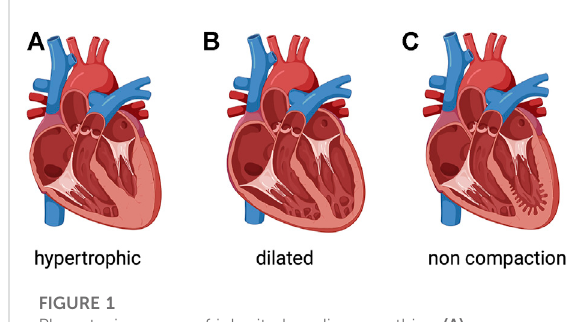
FIGURE 1 Phenotypic groups of inherited cardiomyopathies. (A) Hypertrophic cardiomyopathy involves thickened myocardium, which affects the septum. (B) Dilated cardiomyopathy is characterized by a dilated left ventricle with or without right ventricular involvement. (C) Left ventricular noncompaction is characterized by a noncompacted endocardial layer surrounded by a compacted epicardial layer with marked trabeculation. Created with